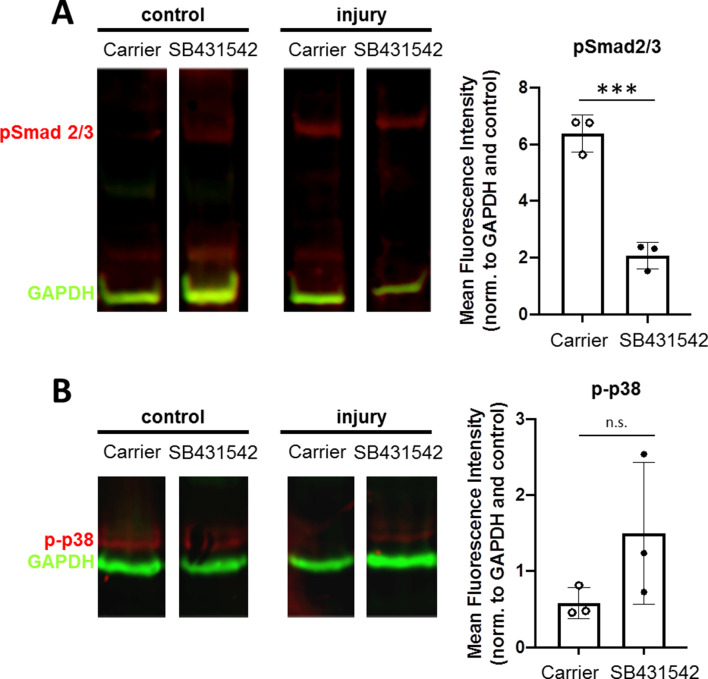
SB-431542 inhibition modulates canonical TGFβ signaling.Western blotting and quantification of (A) pSmad2/3 and (B) phospho-p38 in injured tendons (normalized to GAPDH and control tendons) treated with carrier or SB-431542. *p<0.05 ***p<0.001, n.s. indicates p>0.1.